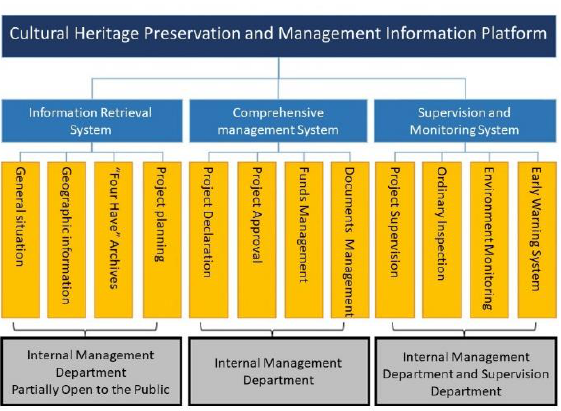
Figure 4. the Framework of the cultural heritage